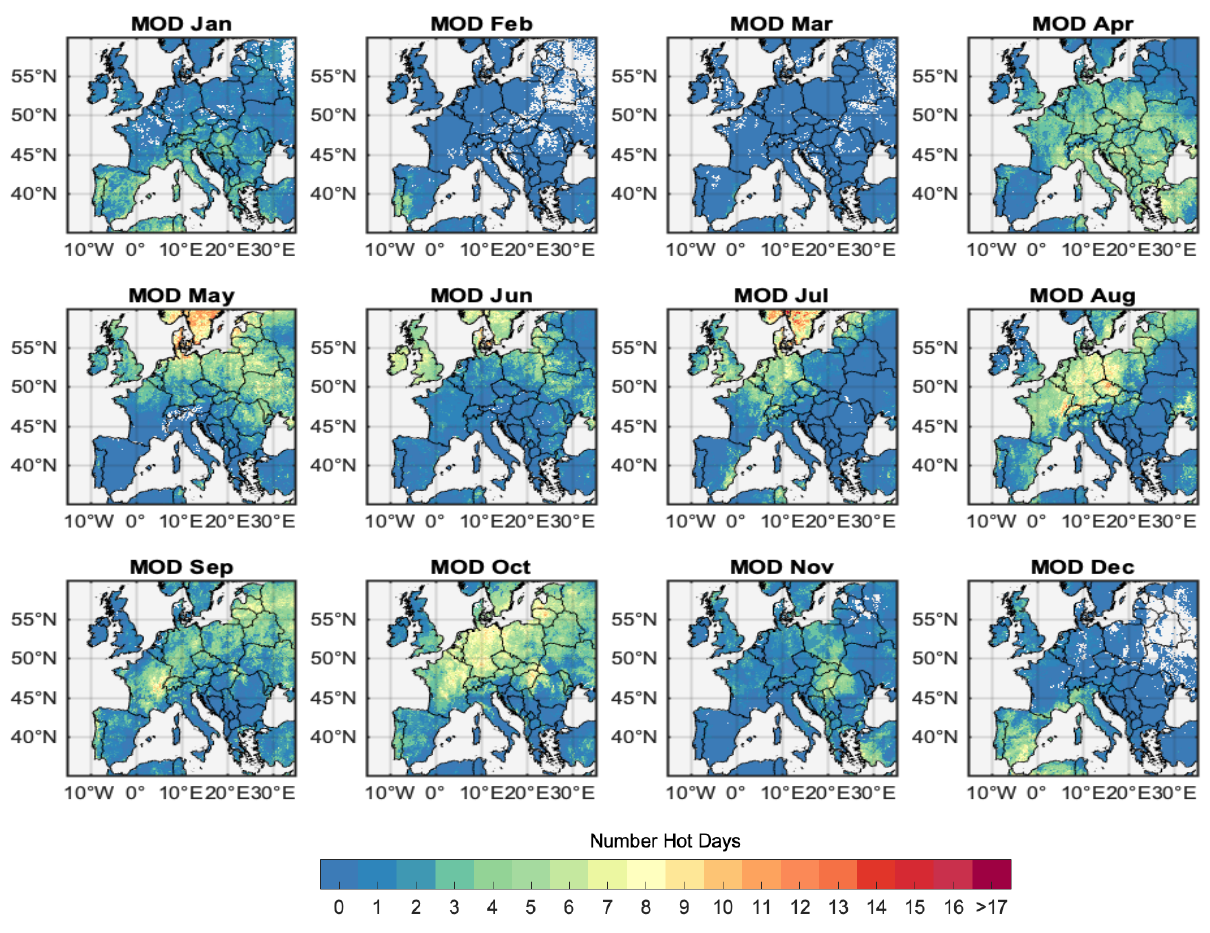
Figure 8. As in Figure 5 but considering MODIS LST (MYD11).